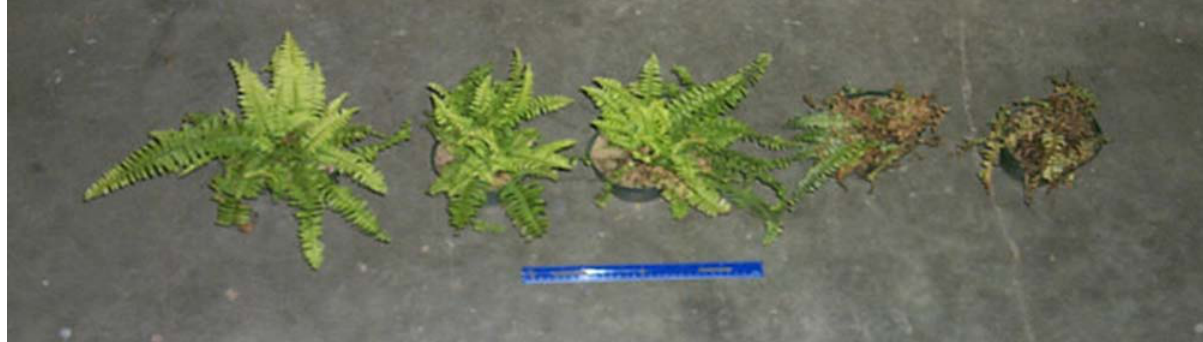
Figure 4. Soil arsenic concentration and plant biomass. Nephrolepis exaltata ferns at 8 weeks in soil/arsenic concentrations of (from left to right) 0, 20, 50, 100 and 200 ppm showing the general effects of increasing soil arsenic on plant growth.